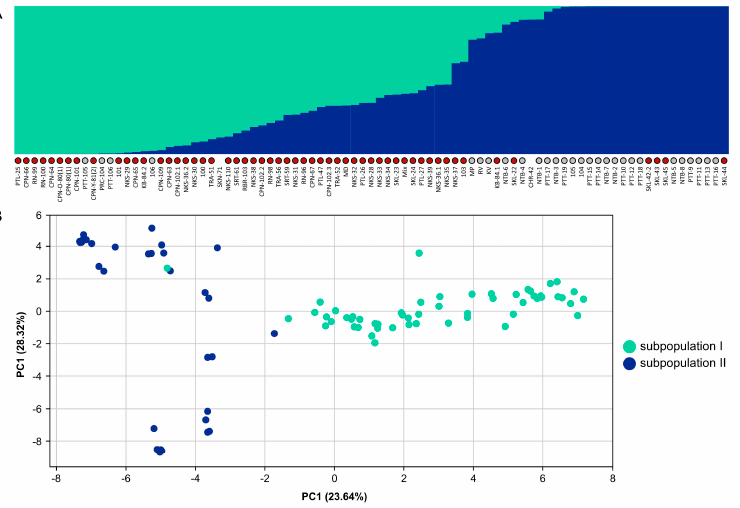
Figure 4. Population structure and genetic diversity of M. speciosa. ( A ) Population structure of 85 M. speciosa accessions. Each accession is represented by a vertical bar, and the length of each color reflects the proportion contributed by ancestral populations. Accessions collected in Western and Southern Thailand are indicated by red dots while those collected in Central Thailand are indicated by grey dots. ( B ) Principal component analysis (PCA) of 85 M. speciosa accessions based on 2492 SNP markers. Each accession is represented by a single dot with colors indicating subpopulations.